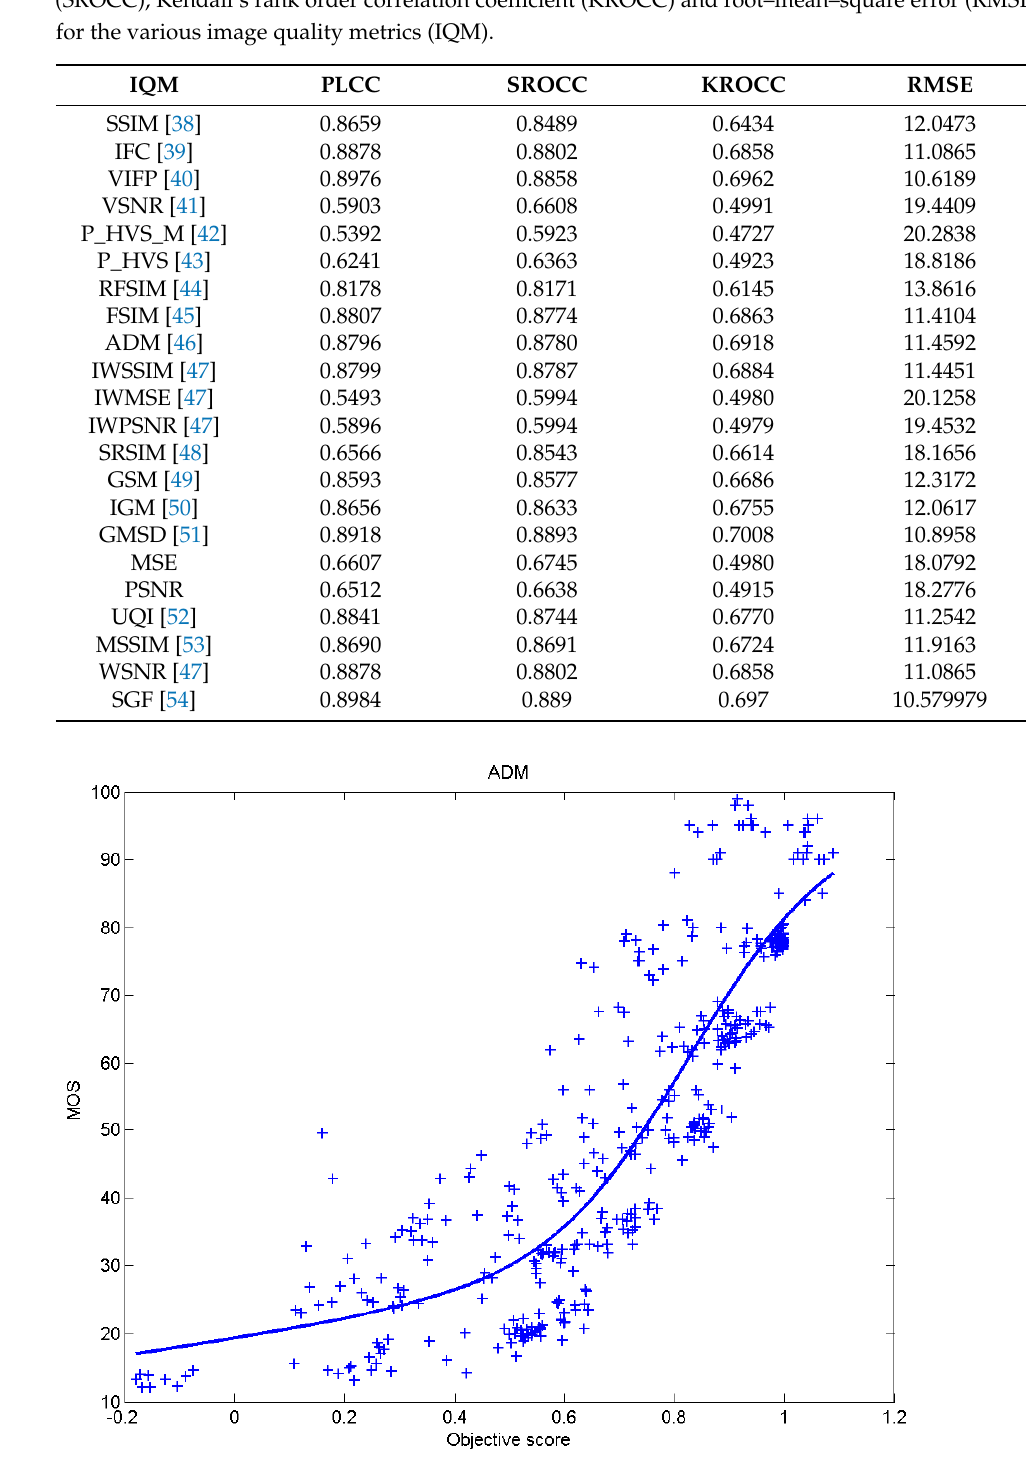
Figure 9. Scatter plots of the subjective scores (MOS) versus ADM.